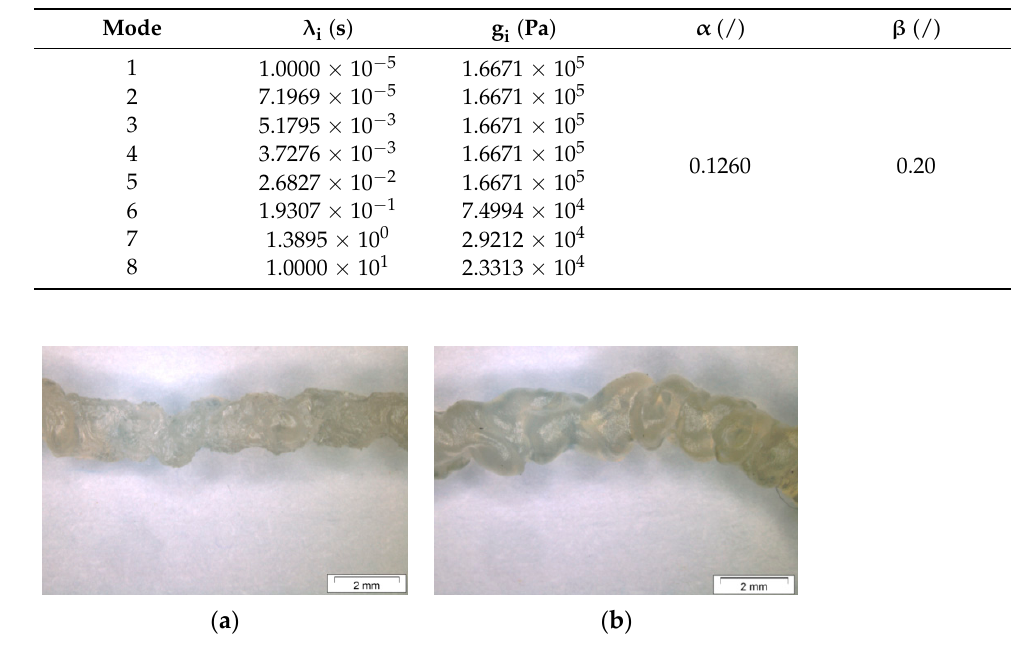
Figure A5. Light microscope images of strands extruded through an abrupt capillary die with a length-to-diameter (L/D) ratio of 10/1 at an apparent shear rate level of ( a ) 27 s − 1 ; ( b ) 30906 s − 1 .